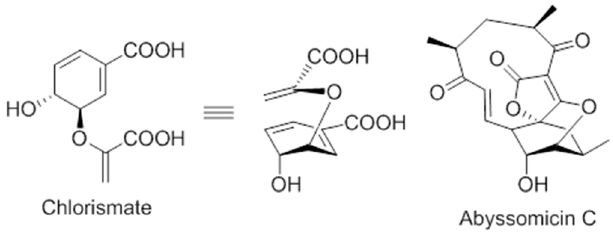
Figure 6. Comparison of the conformations of chorismate and abyssomicin C [63].